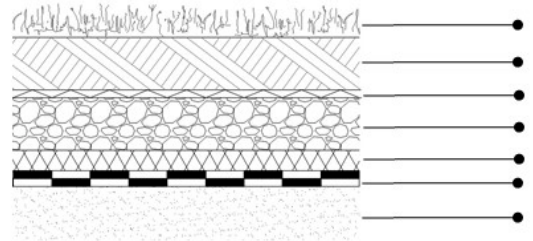
Figure 1. The different layers of a standard green roof.